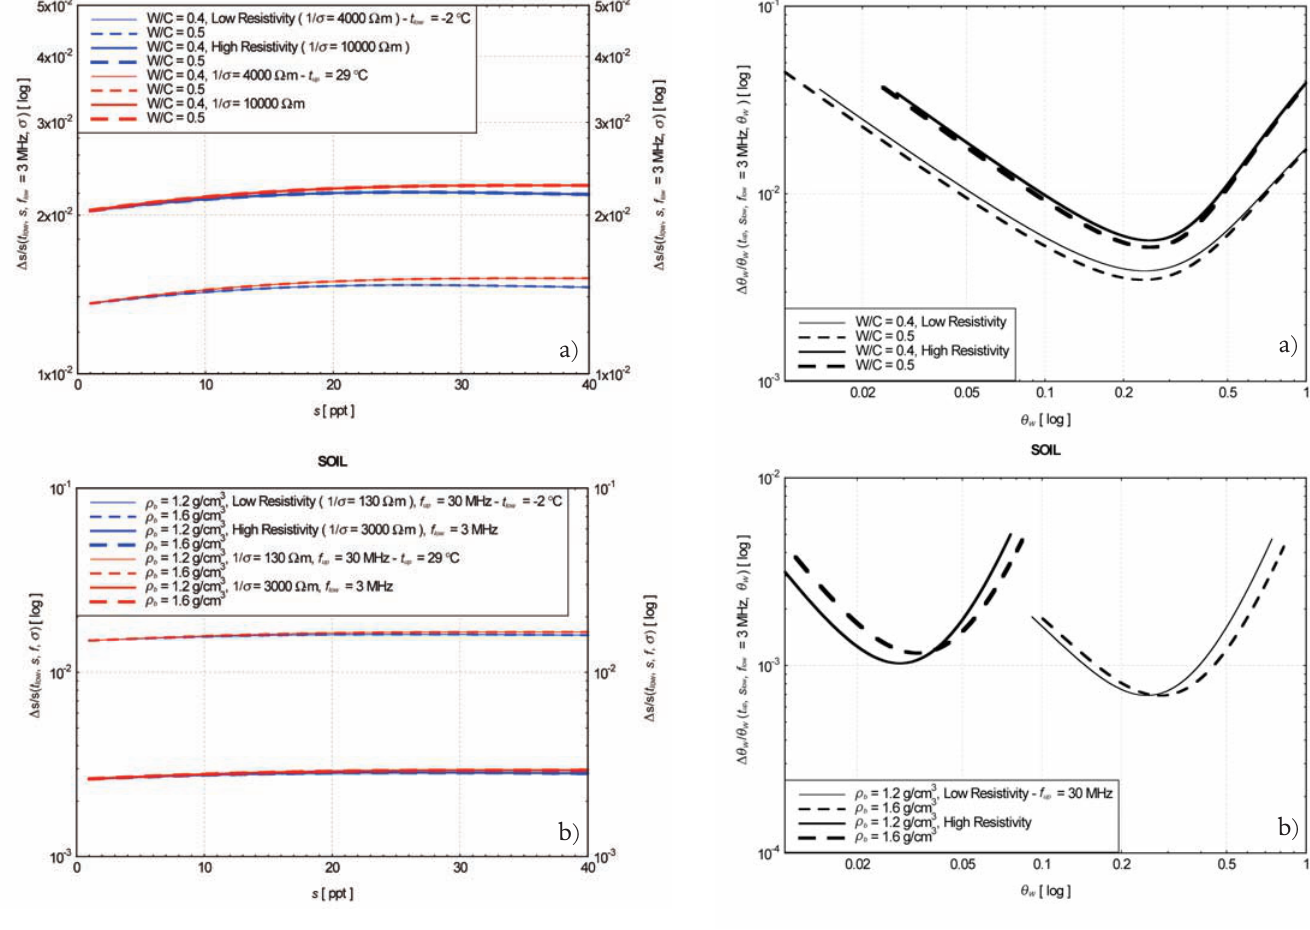
/ i ( t , s , f , i ) as W W up low low,up W , valid within the range W